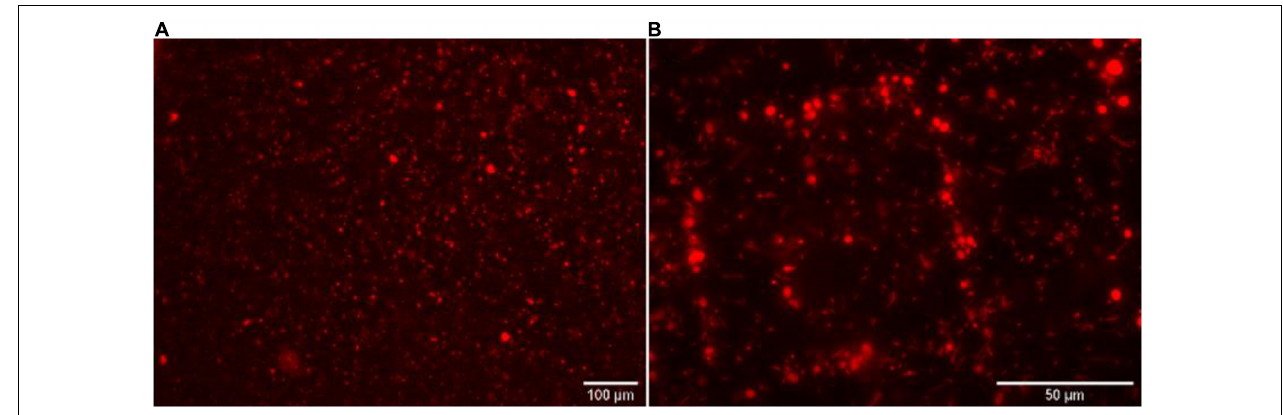
FIGURE 3 | The eukaryotic HCR-MISH specificity as evaluated for target eukaryotic cells in an artificial mixture. E. coli cells were the control test without the specific 18S probe under 50 × magnification (A) and with the 18S probe (B) using a concentration of bacteria 30 times higher than the